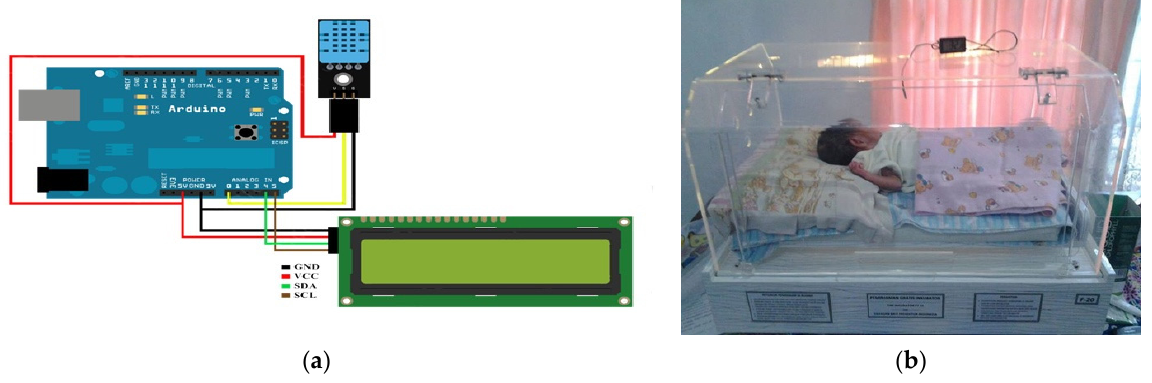
Figure 11. ( a ) Microcontroller Arduino, SHT11 Sensor and LCD and ( b ) Baby Incubator.